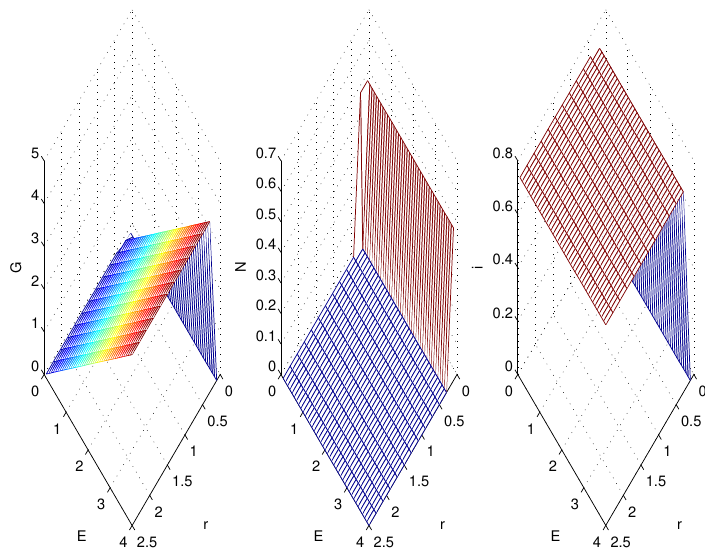
Figure 7. Simulation with µ = 5.0. The red squirrels thrive for low r , independent of E . For small E , they also thrive, but at low population values. The grey squirrel population increases linearly with E